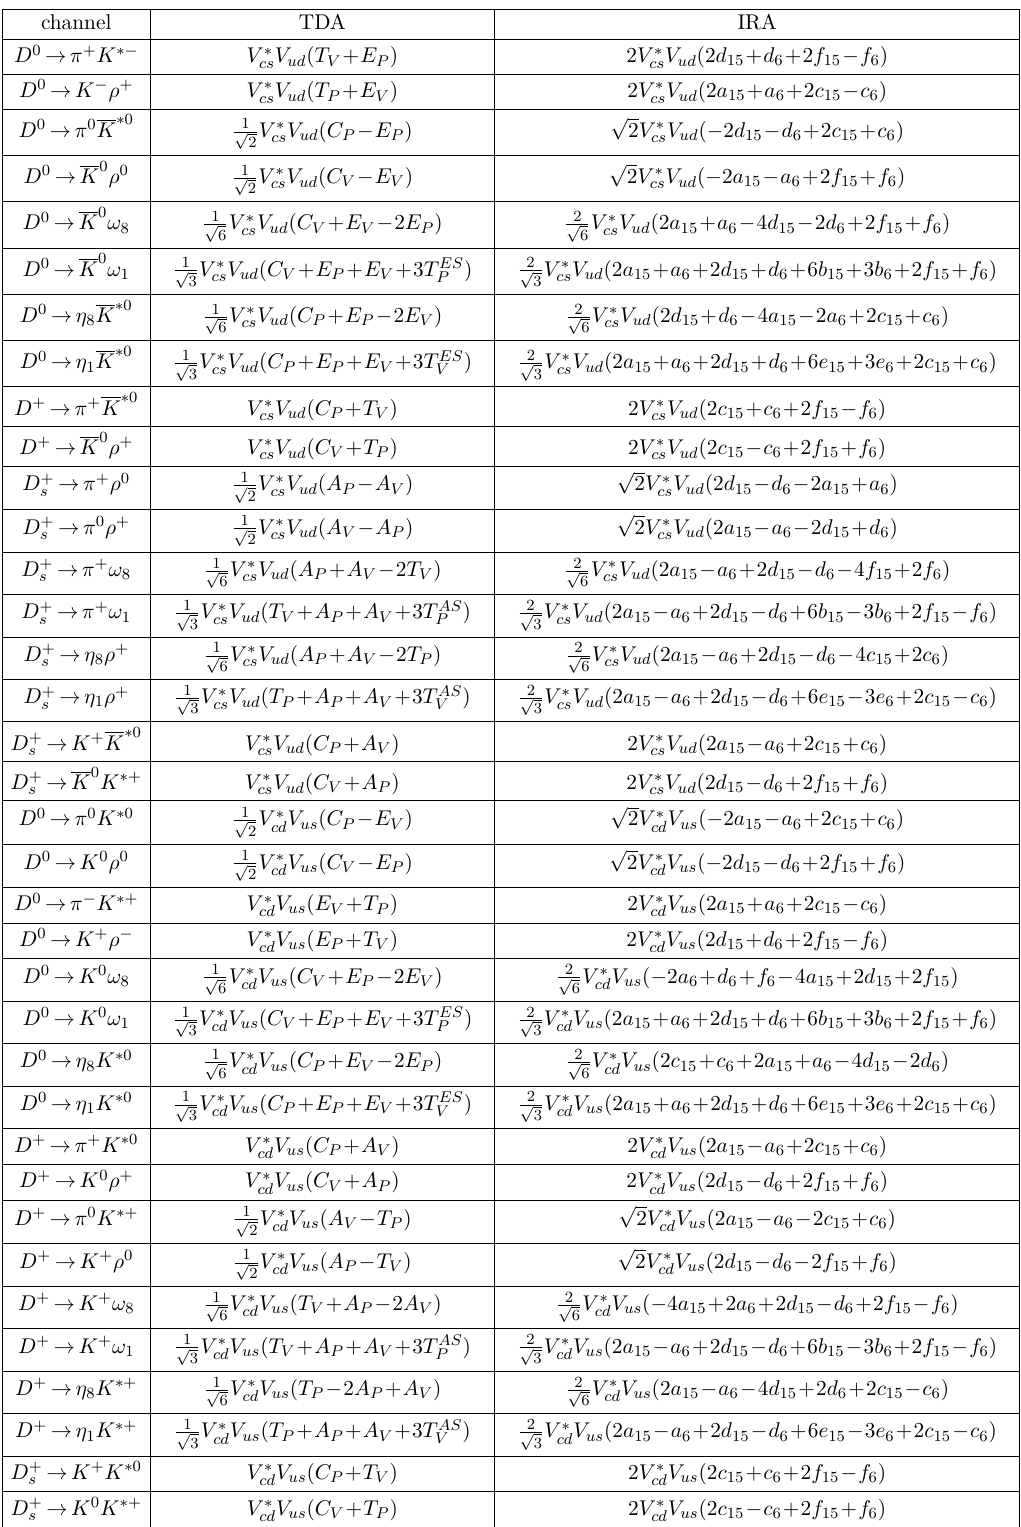
Table 5 . Decay amplitudes of the Cabibblo-allowed and doubly Cabibbo-suppressed D → PV